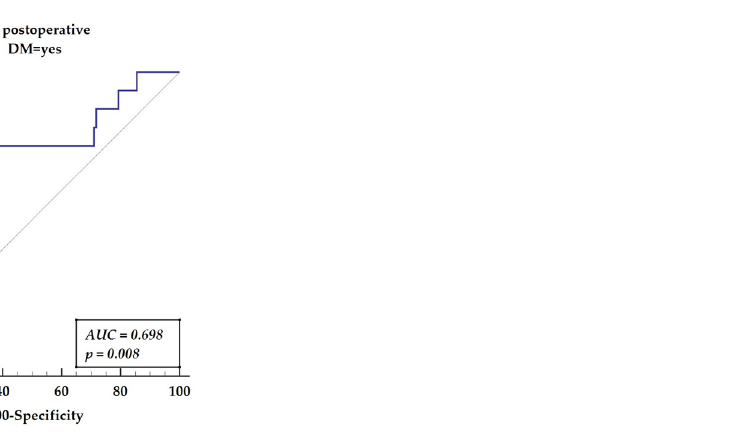
Figure 3. Receiver operating characteristics curve for postoperative SII in DM patients. Abbreviations: AUC—area under the curve, DM—diabetes mellitus, SII—systemic immune-inflammatory index.